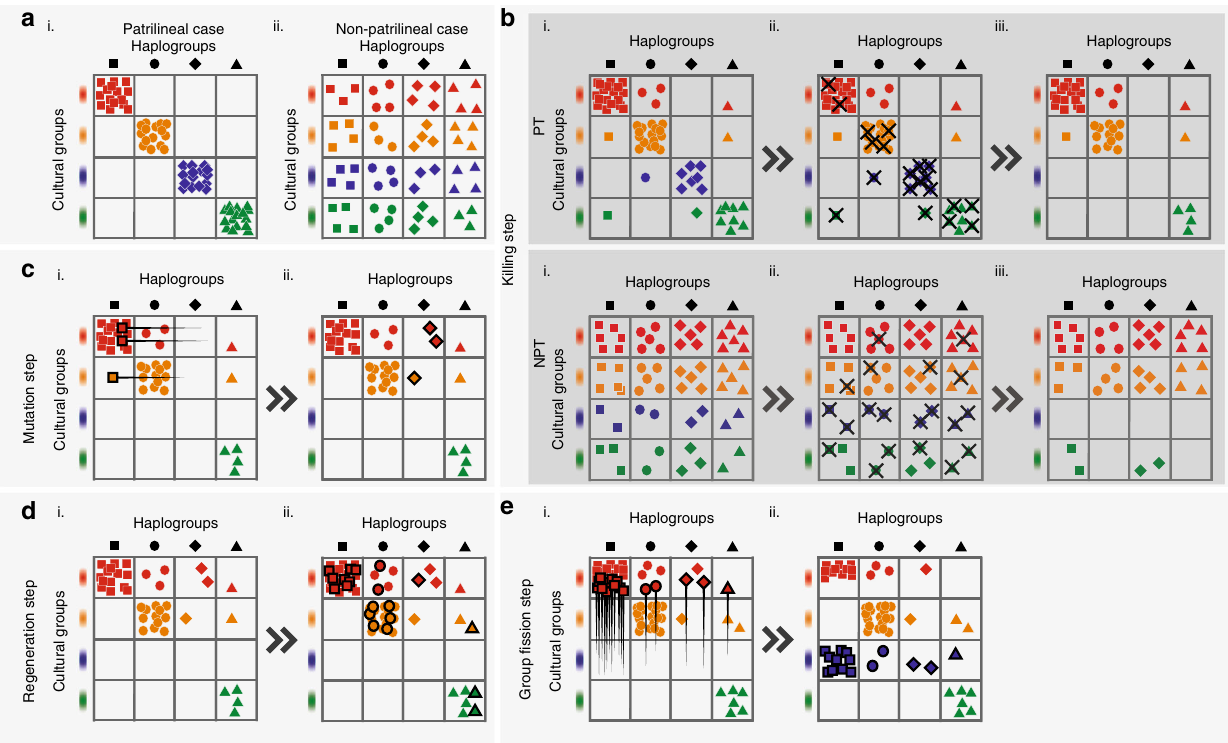
Fig. 4 Schematic of the steps in the simulation, according to the order described in the algorithm. a (i) Patrilineal (PT) starting conditions, where cultural groups strictly determine haplogroup type. a (ii) The non-patrilineal (NPT) condition where they are perfectly uncorrelated. b The killing step, with a more (PT) and less (NPT) patrilineal starting condition. The number of deaths in each group is inversely related to group size. The blue cultural group goes extinct in both cases. This causes the haplogroup represented by the diamonds to go extinct in PT, but no haplogroup extinction occurs in NPT. c The mutation step, where a small number of individuals in the largest haplogroup change their haplogroup. d The regeneration step, where (i) is a replica of ( b ) PT (iii), and ( d ) (ii) shows how the original number of individuals before the killing step is restored by proportionally increasing the number of individuals in all cells. e Group fi ssion step. Where an empty row occurs, the largest cultural group splits, and half the individuals form a new cultural group in the empty row. The step in which we remove cultural groups that are too small — between ( c , d ) (see Methods) — is not shown